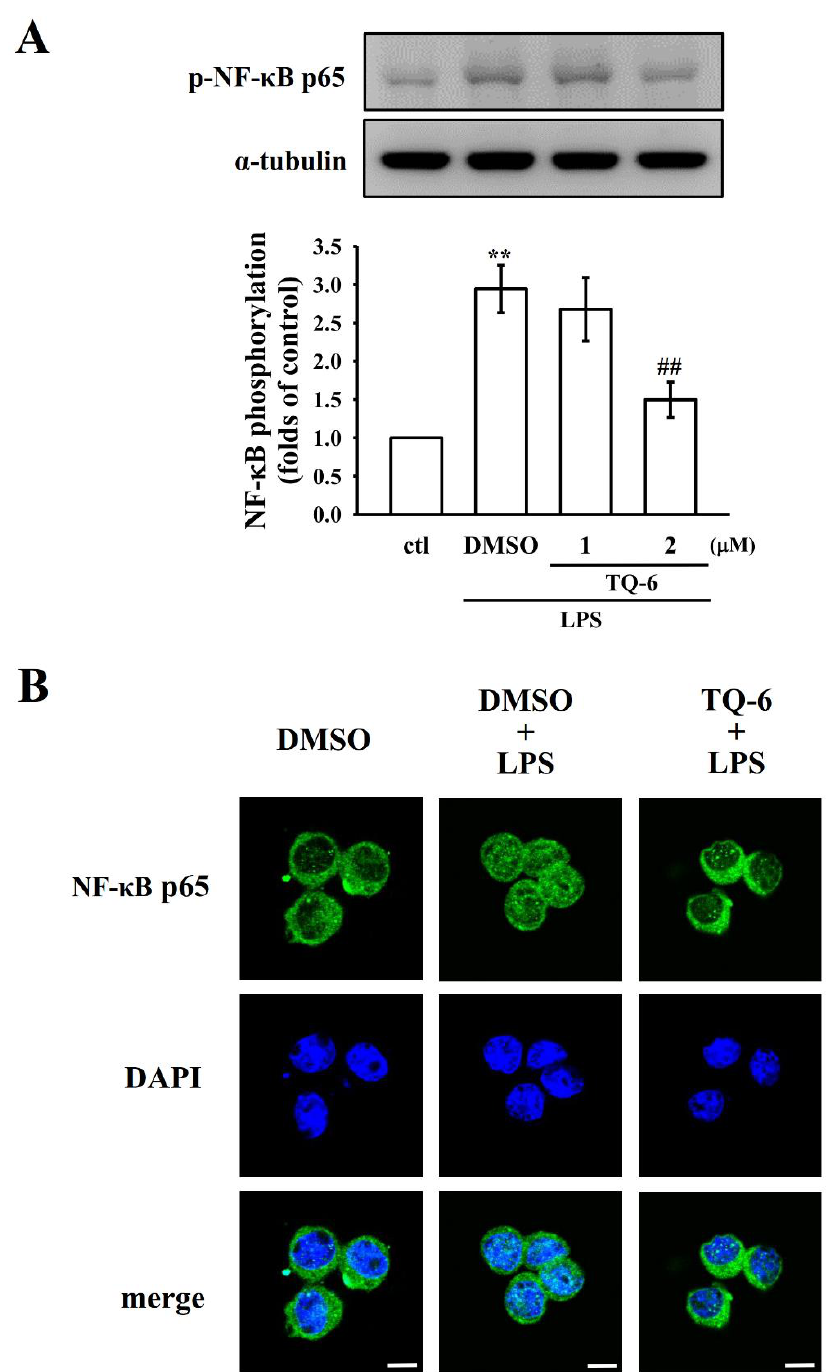
Figure 2. Inhibitory e ff ect of TQ-6 on NF- κ B p65 phosphorylation and nuclear translocation in LPS-stimulated microglia. ( A ) Cells were treated with 0.1% DMSO or TQ-6 (1 or 2 µ M), followed by LPS (1 µ g / mL) for 30 min for immunoblotting assay. ( B ) The immunofluorescence analysis was performed with an anti-NF- κ B p65 antibody and fluorescein isothiocyanate (FITC)-conjugated anti-rabbit immunoglobulin G (IgG; green). 4’,6-diamidino-2-phenylindole (DAPI) was used to label the nuclei (blue). The images were captured through confocal microscopy (scale bar = 7.5 µ m). Data are presented as mean ± SEM ( n = 4). ** p < 0.01 compared with control (ctl); ## p < 0.01 compared with the LPS-treated